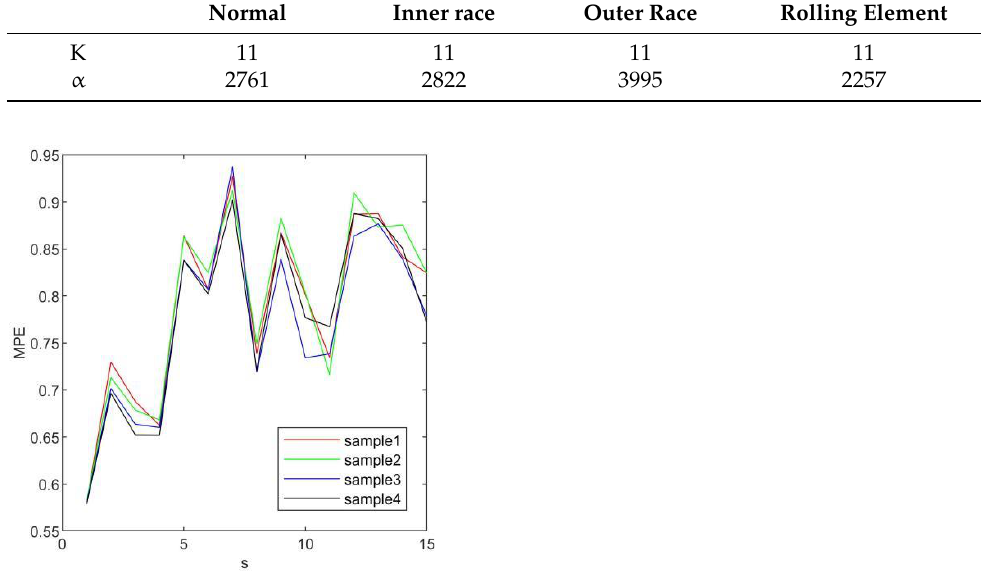
Figure 6. Minimum mean envelope entropy iteration curve. Table 2. Optimization parameters obtained by using the ISSA.